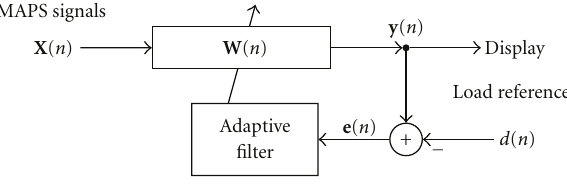
Figure 7: Hybrid adaptive filter.